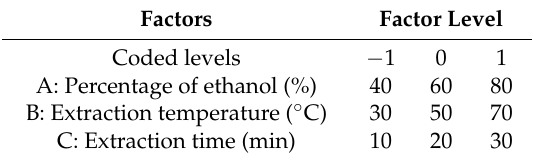
2. The experimental values for